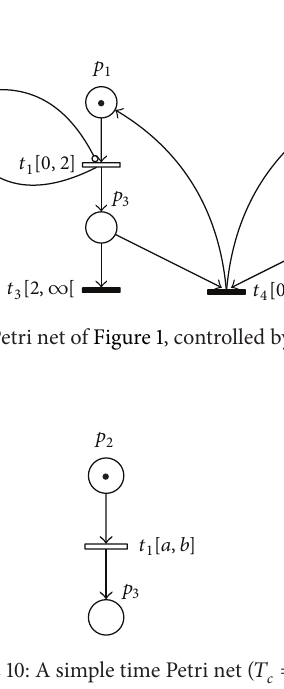
𝑡 1 in a controlled TPN associated with stopwatch is Figure 8 represents the clock evaluation of the transition 𝑡 1 .